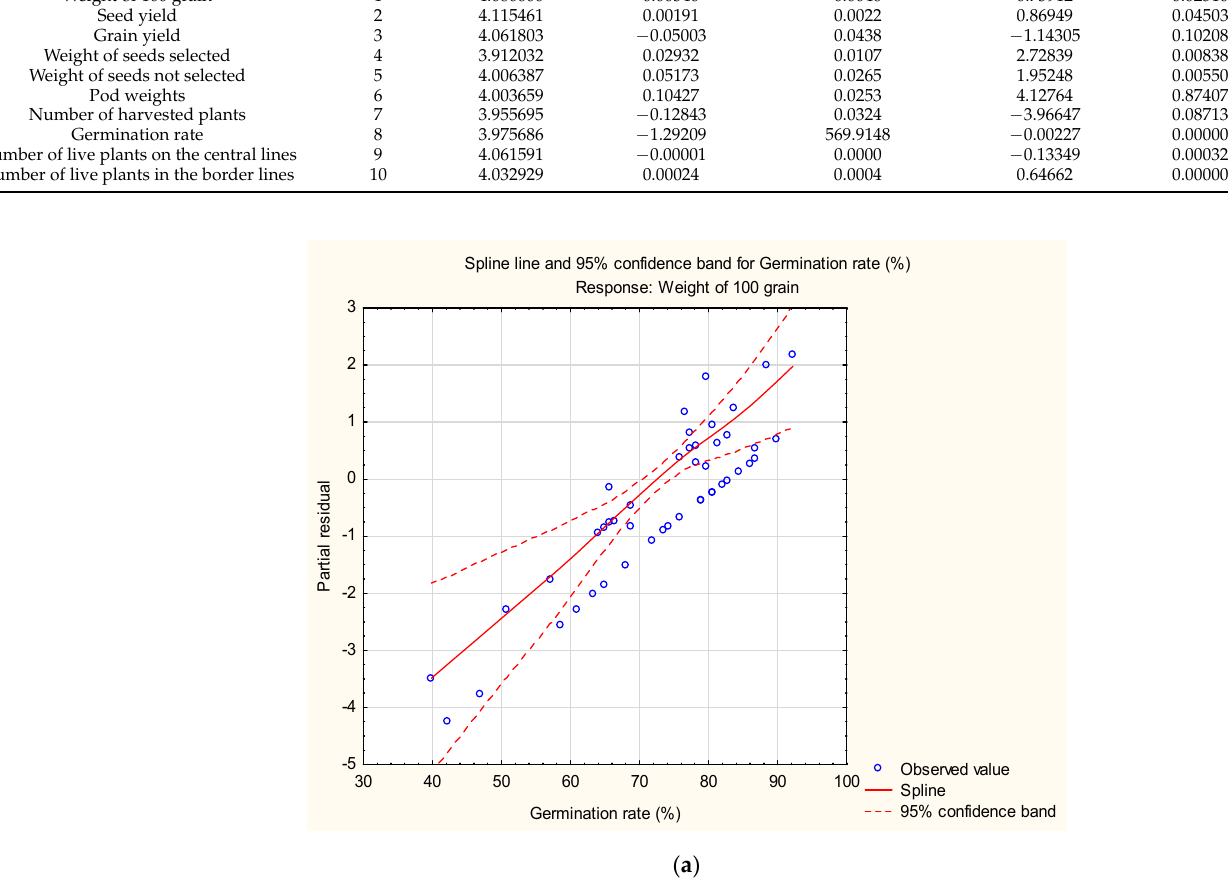
Spline line and 95% confidence band for Number of live plants on the central lines Response: Weight of 100 grain